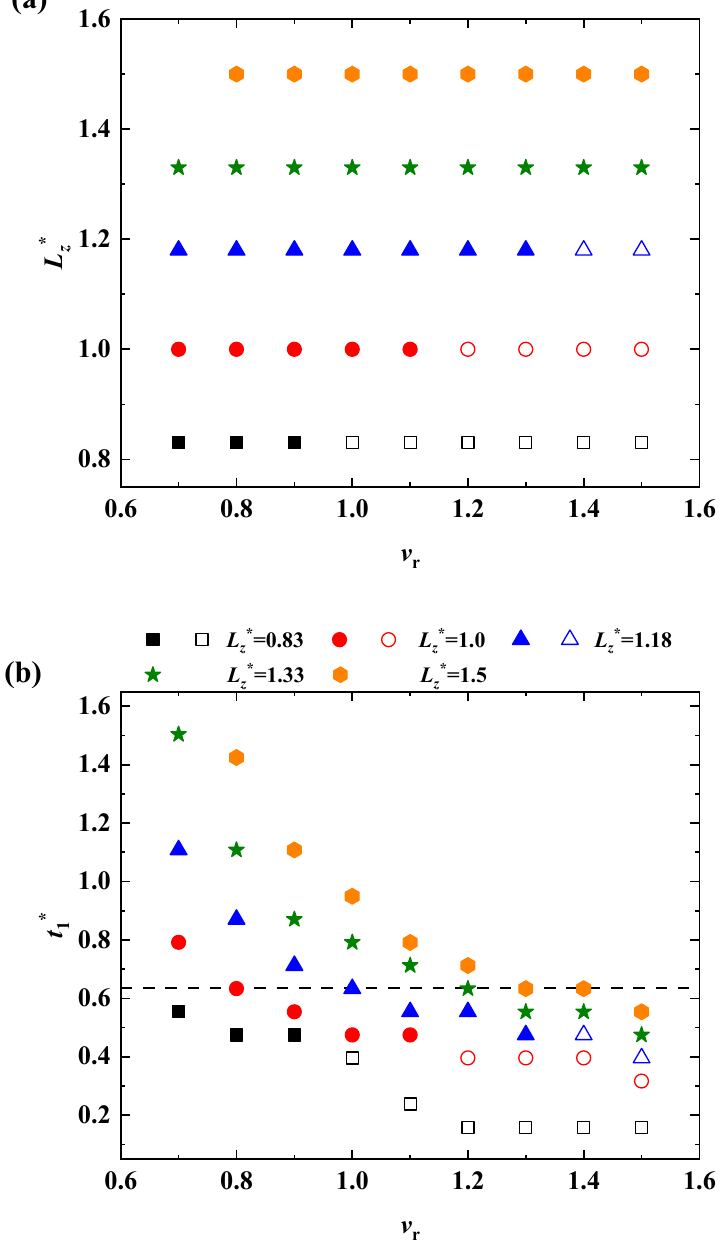
Figure 5. ( a ) Map for rebounding regime of two successive impacting droplets with various v r and L z * ; ( b ) Variation of coalescence time t 1* of two droplets for v r at various L z * .